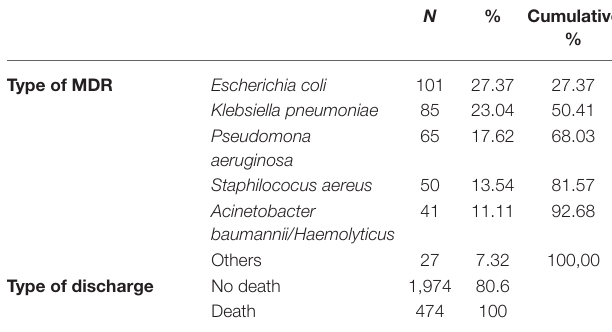
TABLE 1 | Baseline characteristics of inpatients with COVID-19, February 2020 to February 2021.